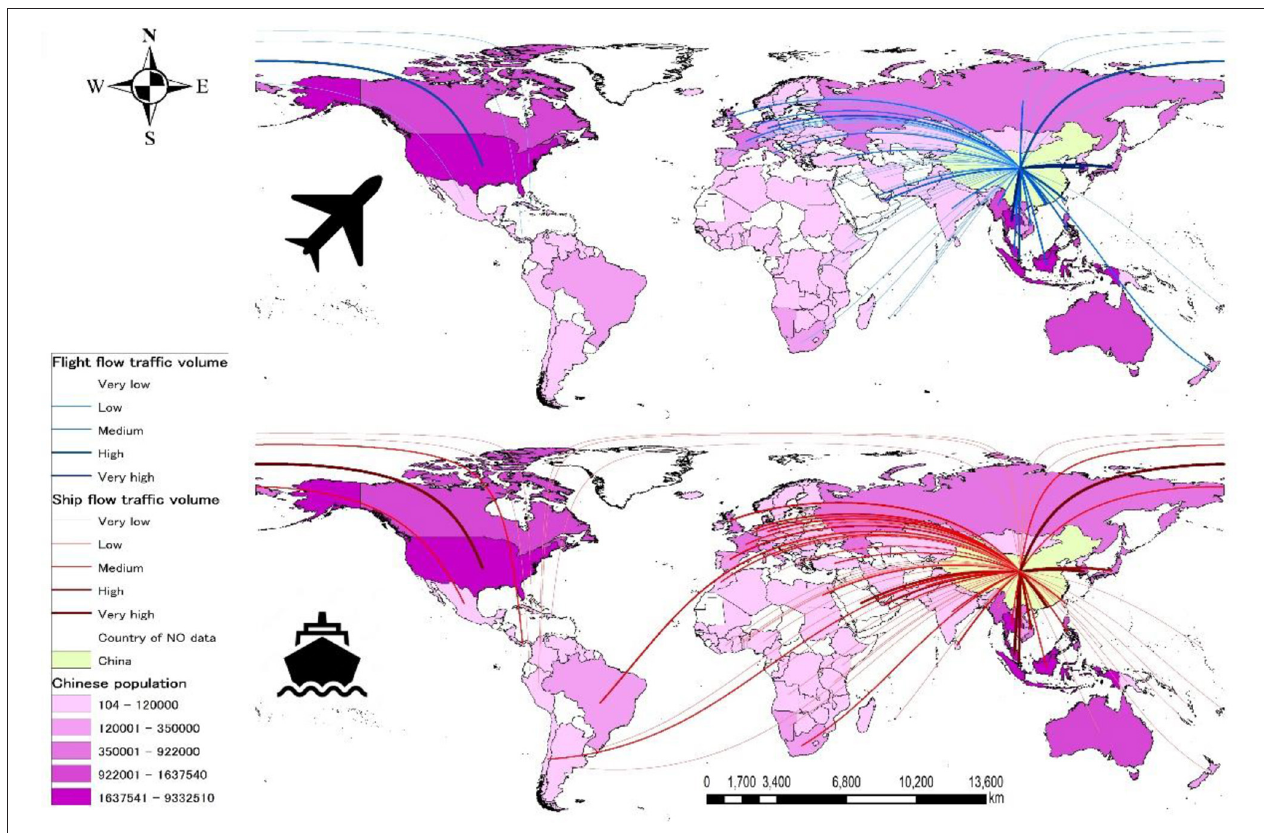
FIGURE 4 | The flight and ship flows connected to China combined with the distribution of Chinese overseas residents. The flight flow and ship flow from China are depicted above and below, respectively. The graduated color and width in the map represent the total traffic volume from the highest (darker/thicker) to the lowest (lighter/narrower). Each line indicates total traffic volume of > 1.81 × 10 7 (very high), 8.91 × 10 6 to 1.8 × 10 7 (high), 2.91 × 10 6 to 8.9 × 10 6 (medium), 9.51 × 10 5 to 2.9 × 10 6 (low), and < 9.5 × 10 5 (very low) seats in flight flow. For ship flow, each line indicates total traffic volume of > 7.51 × 10 6 (very high), 3.61 × 10 6 to 7.5 × 10 6 (high), 2.21 × 10 6 to 3.6 × 1 0 6 (medium), 7.51 × 10 5 to 2.2 × 10 6 (low), and < 7.5 × 10 5 (very low) per quarterly deployed capacity (TEU). In each map, the graduated color represents the number of Chinese overseas residents from the highest (darker) to the lowest